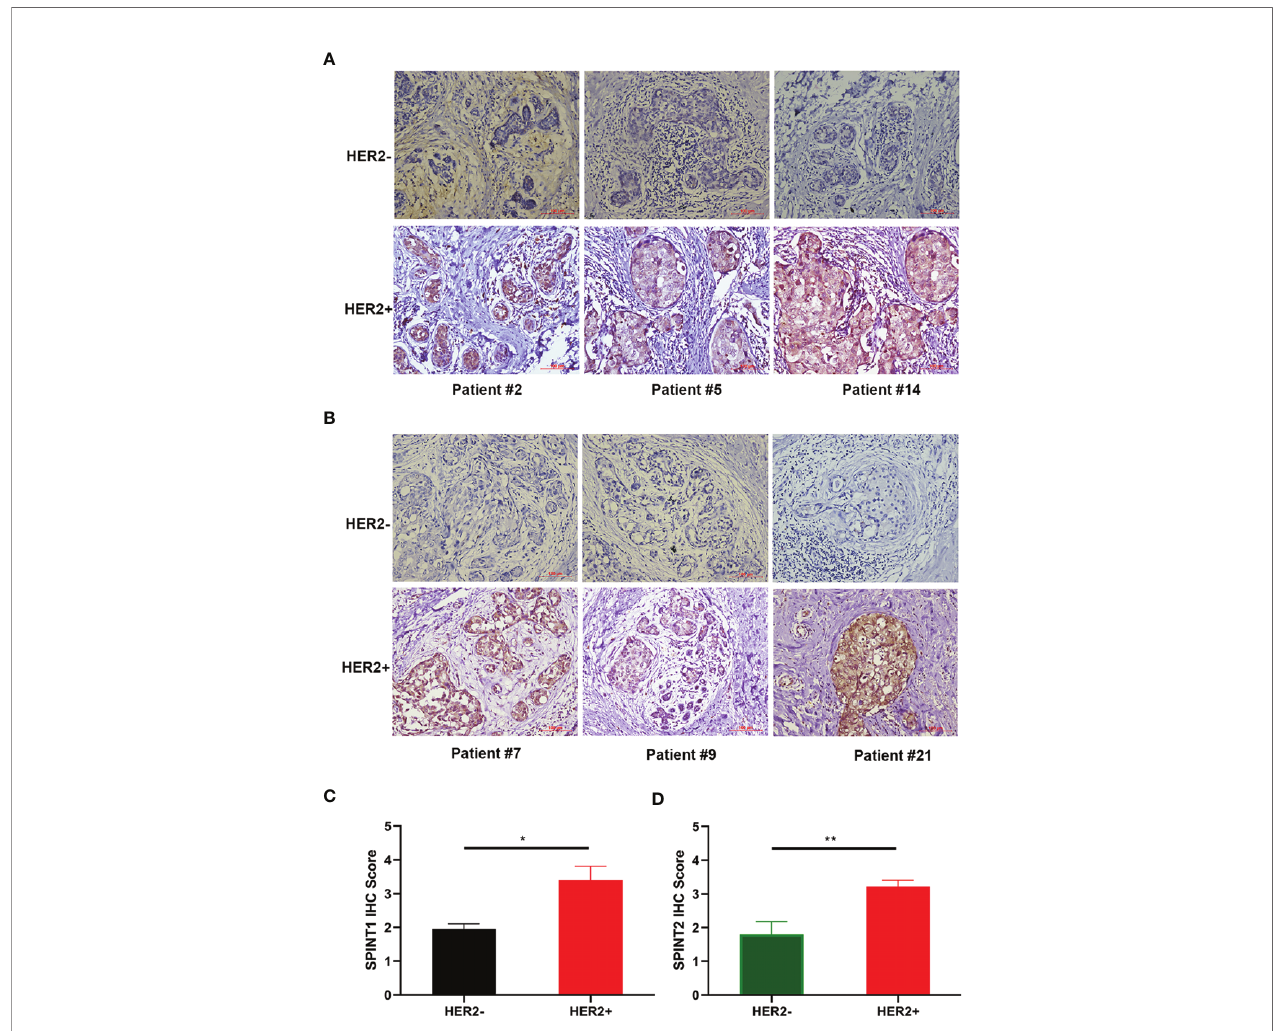
FIGURE 3 | Protein expression of SPINT1/2 in HER2+ breast cancer. Representative images of SPINT1 (A) and SPINT2 (B) expression in cancer tissues. Semiquantitative results of SPINT1 (C) and (D) expression in HER2± breast cancer. * P < .05 and ** P <